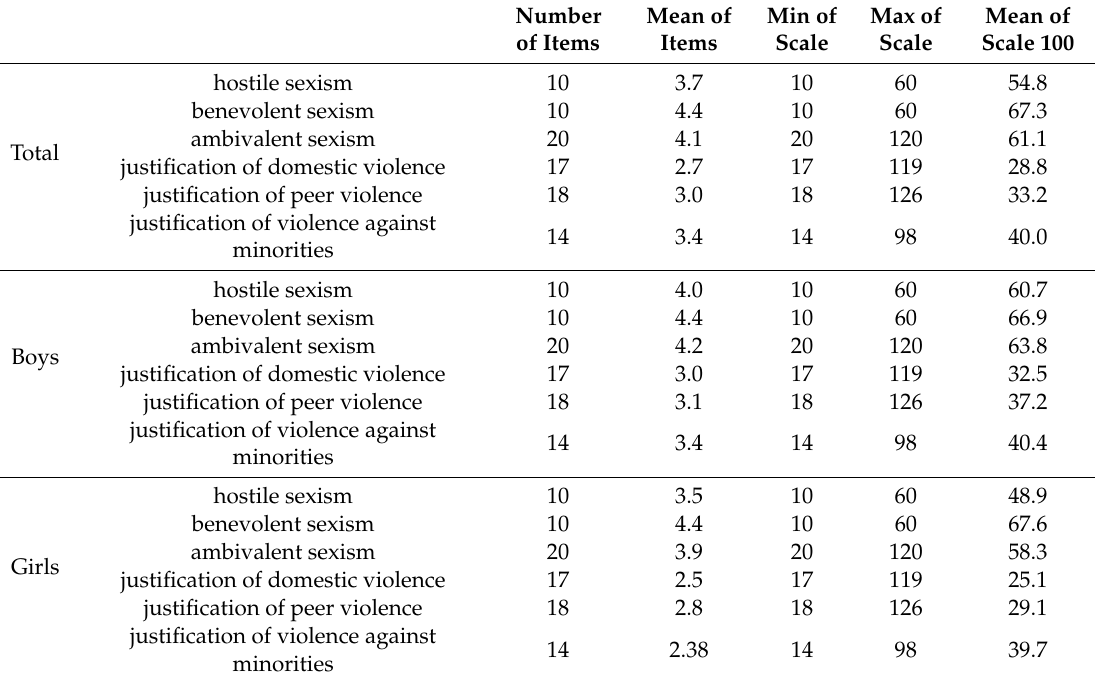
Table A3. Descriptive statistics of scales—total, boys and